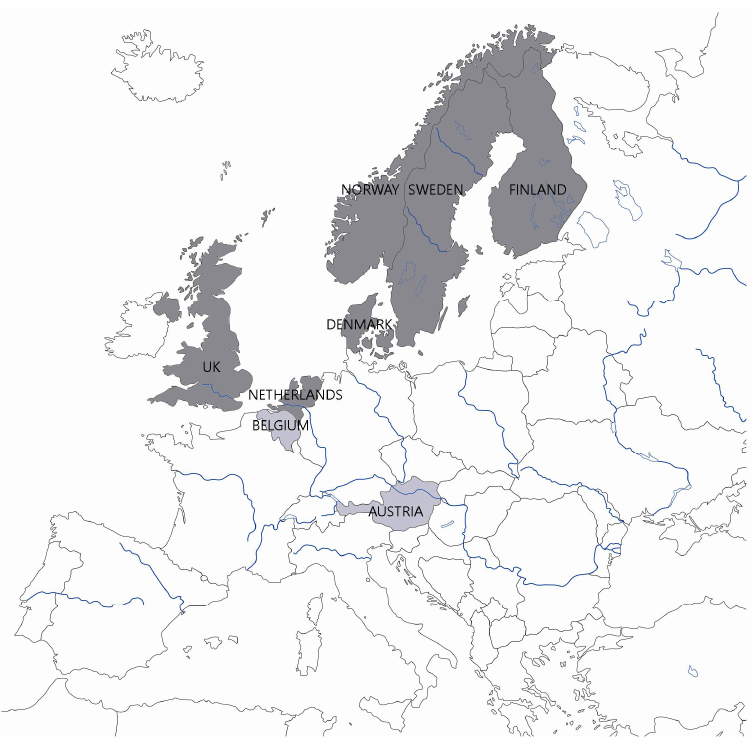
Figure 2. Before 2014: in dark gray, the European countries with a regulation on BIM; in light gray, the European countries with guidelines.